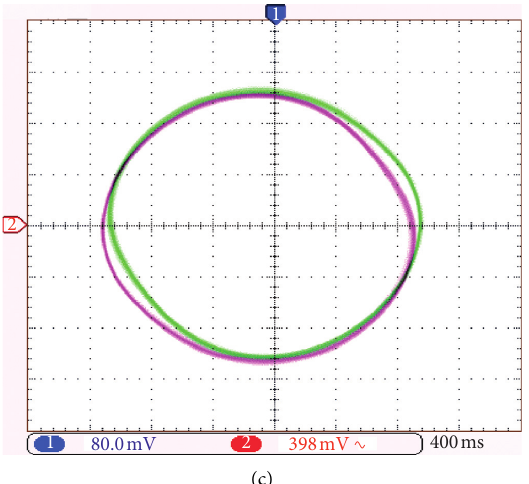
Figure 7: Hidden attractors by DSP implementation; initial values: (5.9 0.3720–8.4291) (magenta) and (–5.9 –0.3720 8.4291) (green): (a) x - y plane; (b) x - z plane; (c) y - z